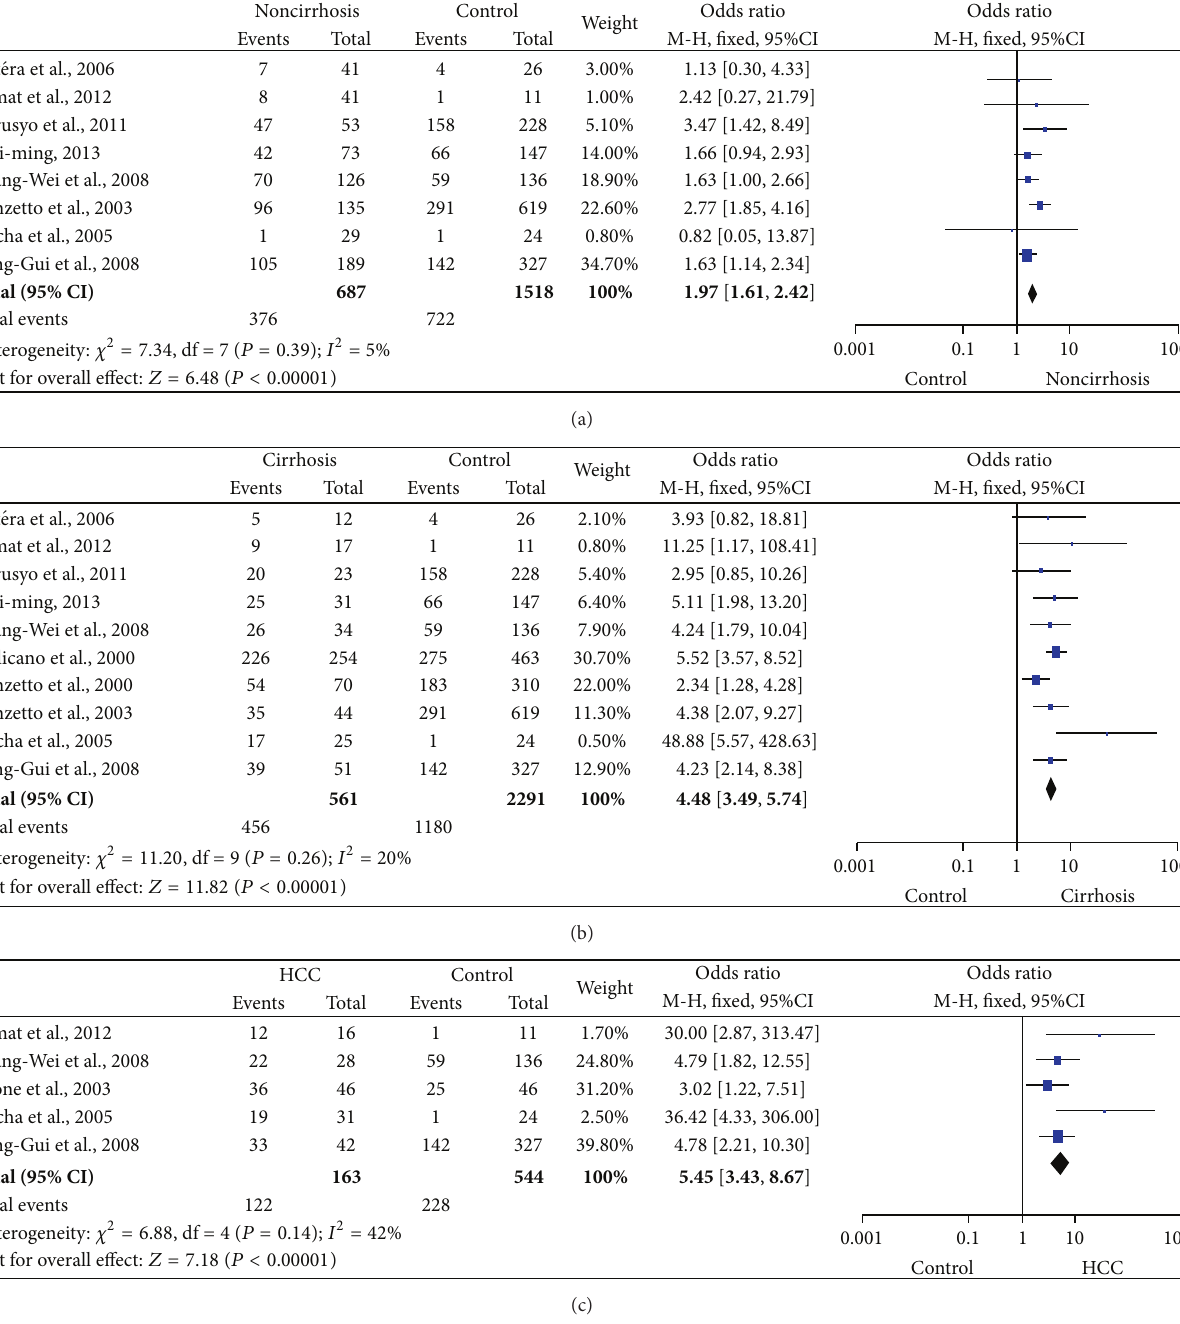
Figure 3: Forest plots of a meta-analysis depending on HCV progression stage. HCC: hepatocellular carcinoma; M-H: Mantel-Haenszel.